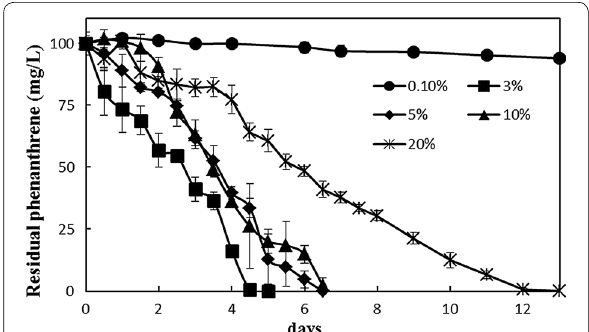
Fig. 1 Effect of salinity on phenanthrene degradation by halophilic consortium CY-1. Consortium was cultivated batch-wise (second round) in SSDM under 0.1, 3, 5, 10 and 20% (w/w) salinity at 30 °C, 150 rpm. Samples were collected in the degradation process from day 1 to day